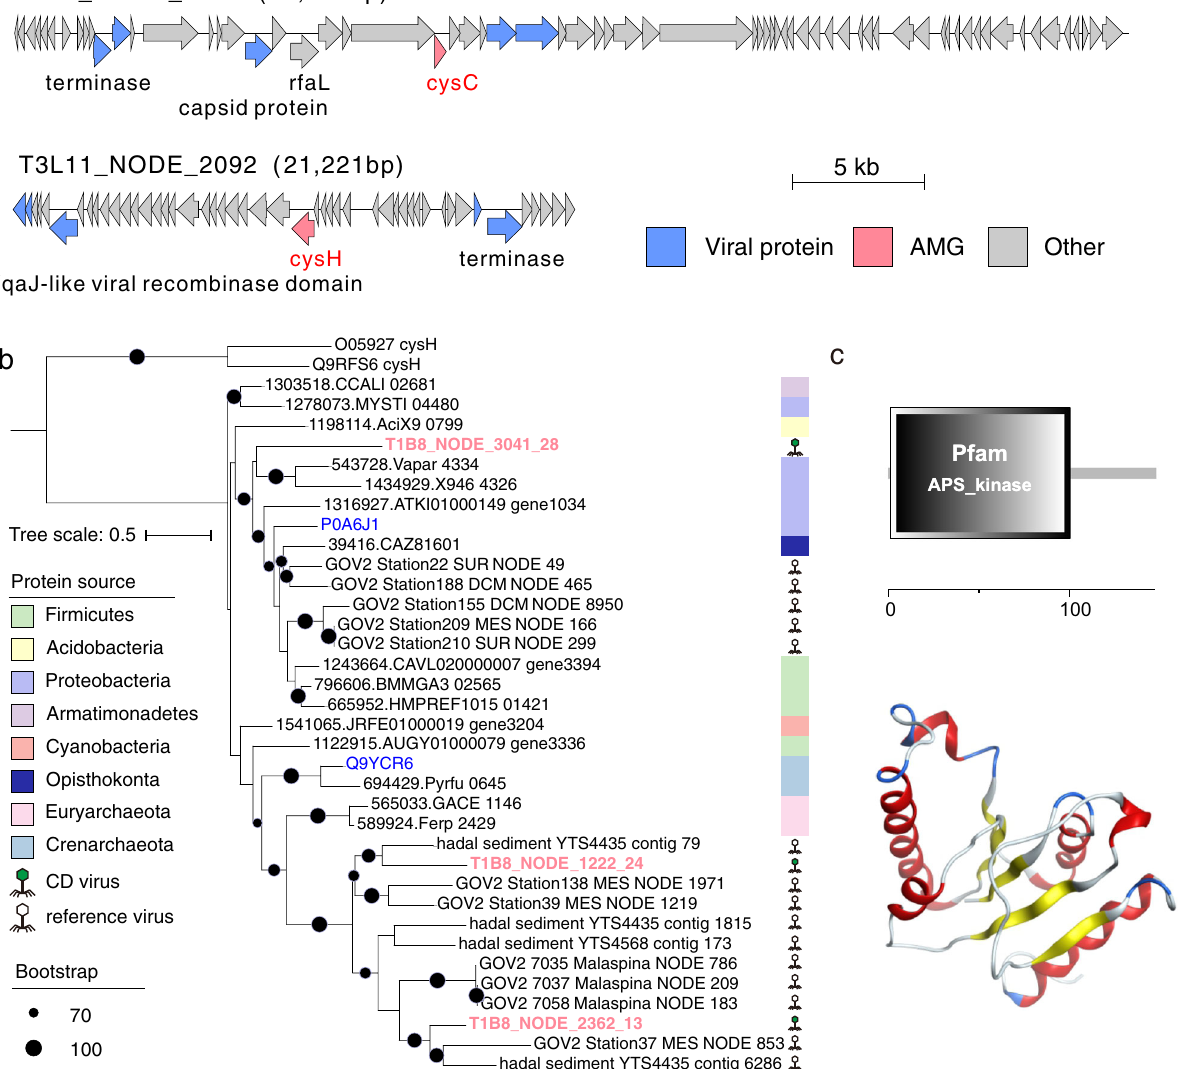
Fig. 6 Genomic analysis of viral assimilatory sulfate reduction genes. a Genome maps of two viral contigs containing sulfate reduction related genes. Genes encoding viral proteins were annotated by CheckV. AMGs, viral-speci fi c and non-phage-like, and uncharacterized genes are shown in pink, blue, and gray, respectively. CysC/H and viral-speci fi c proteins are labeled. Detailed function annotations of genes in viral contigs are listed in Supplementary Data 8. b Maximum-likelihood phylogenetic tree of CD CysC proteins. The CysC proteins predicted in CD viral genomes were used to construct a phylogenetic tree using homologous CysC proteins deposited in the eggNOG database (V5.0) and publicly available viral data sets. CysH proteins were used as an outgroup. We also included two CysC homologs from the Uniport database (in blue) with experimental evidence of function at the protein level. Bootstrap values (1000 replicates) ≥ 70% are indicated at nodes. c Functional domain and three-dimensional structure of CysC protein